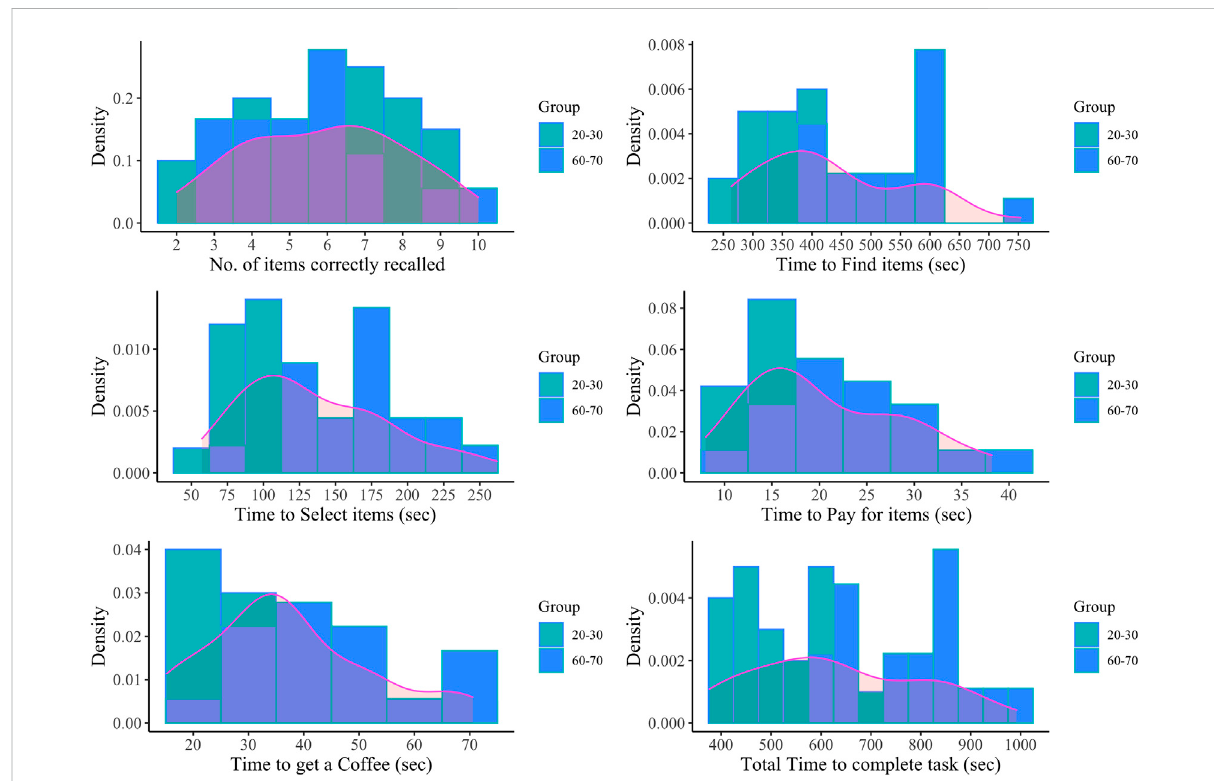
FIGURE 7 Study 2 frequency distributions (in green and blue) and density plots (in pink) for VStore Recall, Find, Select, Pay, Coffee, and